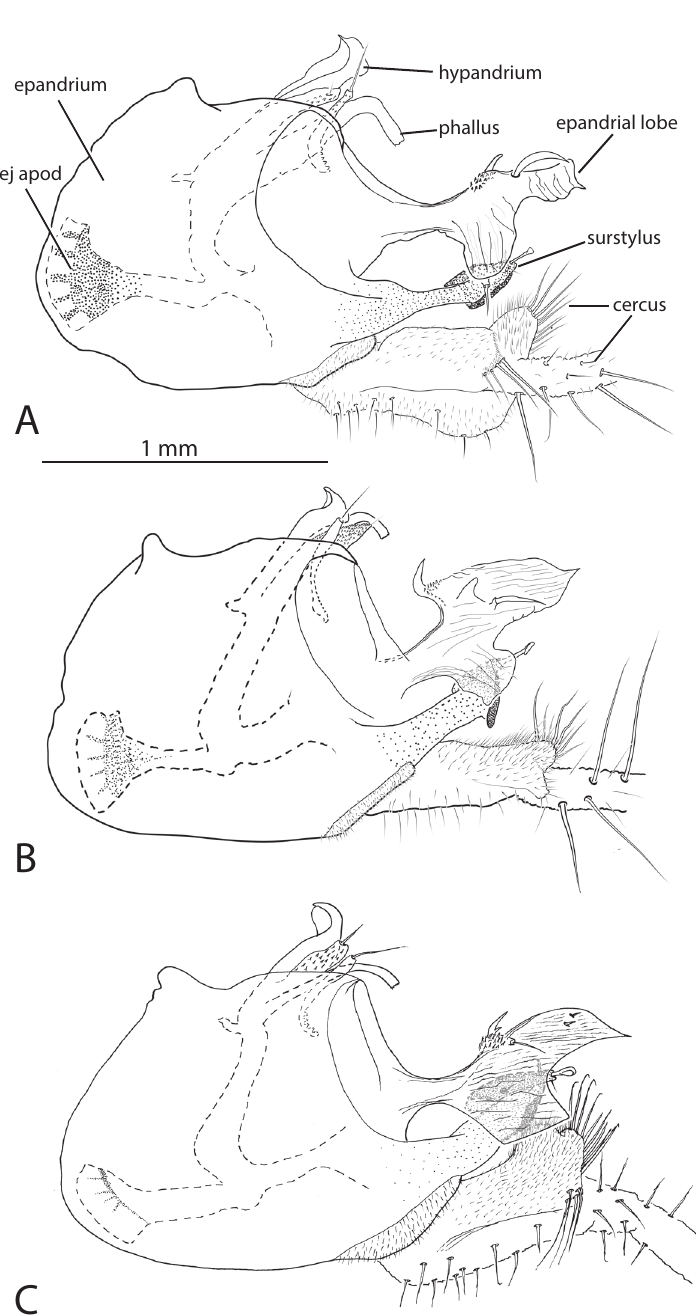
Figure 10. Liancalus male terminalia, right lateral view of A L. genualis Loew B L. sonorus sp. n., and C L. limbatus Van Duzee. ej apod = ejaculatory apodeme. Scale bar = 1 mm. Only base of cercus shown, see Fig. 2 for photographs of entire